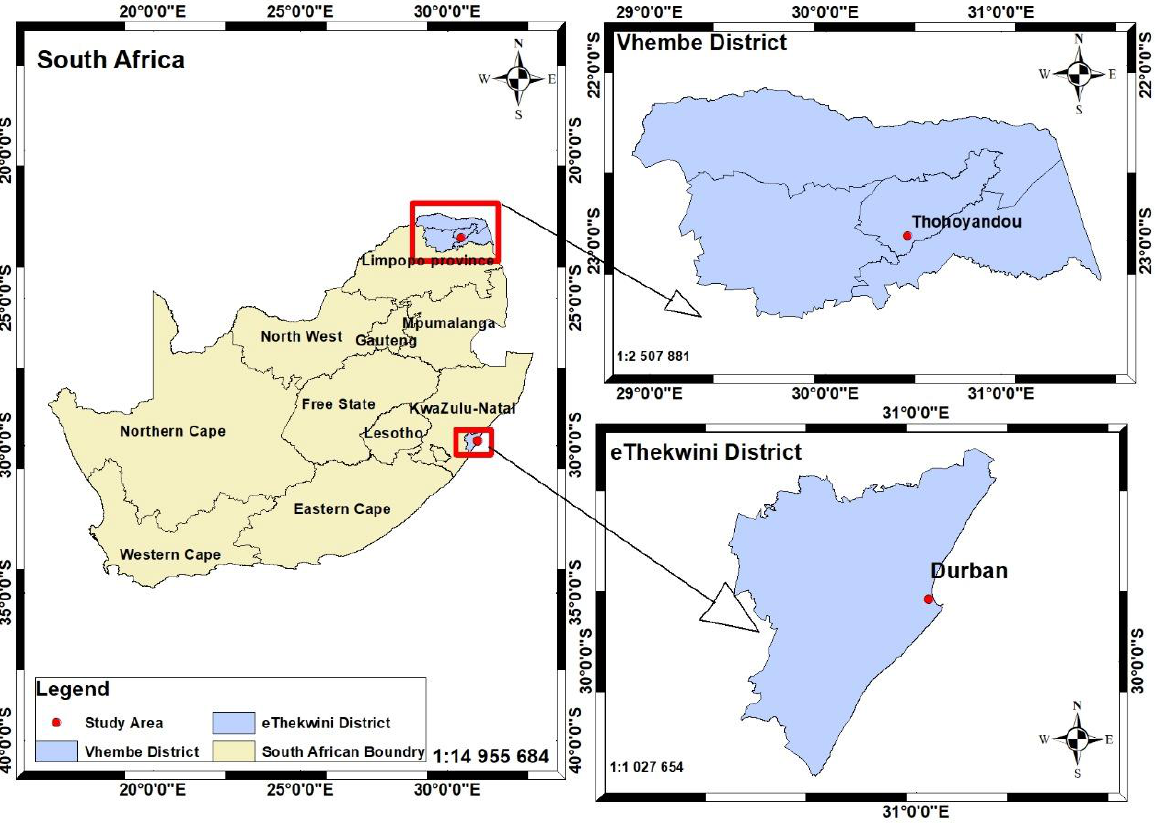
Figure 1. Map of the study areas.